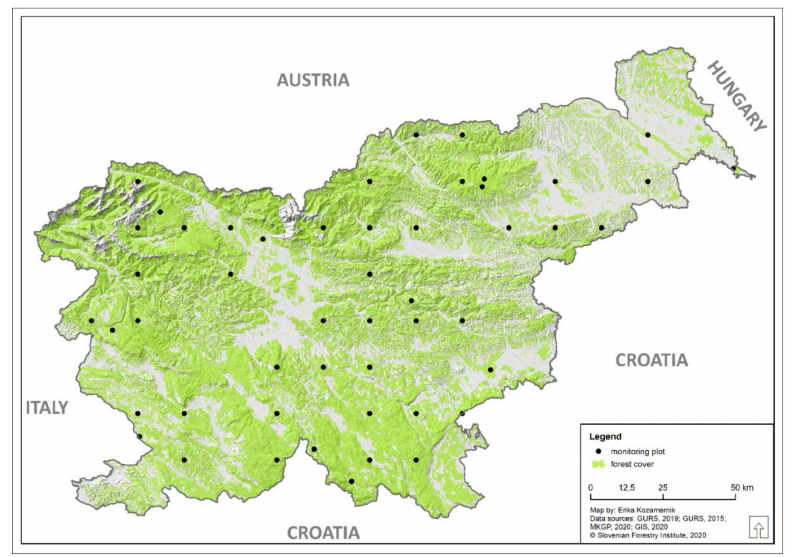
Figure 1. Distribution of 50 monitoring plots across Slovenia, belonging to the International Co- operative Programme on the Assessment and Monitoring of Air Pollution Effects on Forests (ICP Forests) Level I and Level II network. Map creation: Erika Kozamernik, Slovenian Forestry